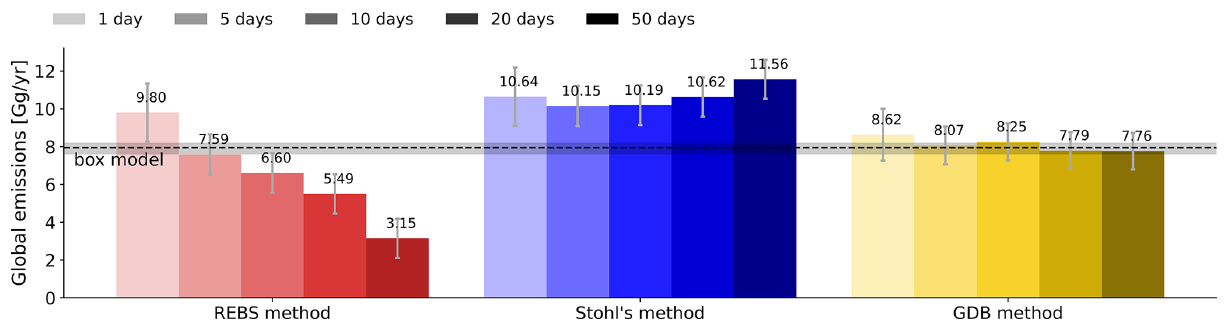
Figure 10. SF 6 global emissions derived by the inversions. Results are shown for the three applied baseline methods and for the five applied backward simulation periods between 1 and 50d. The horizontal dashed line represents the reference value of the AGAGE 12-box model with shaded error bands. Uncertainties represent a 1 σ